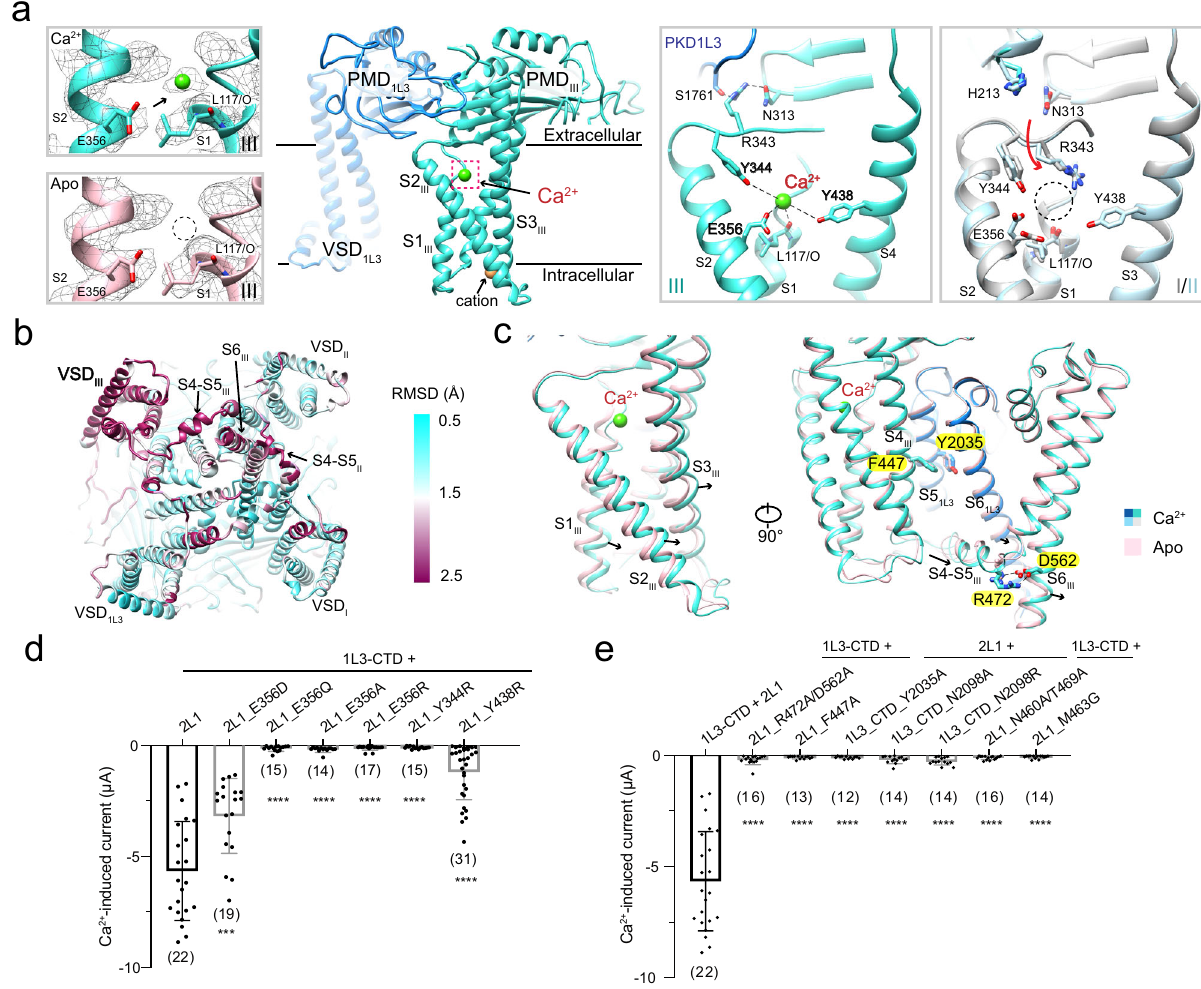
Fig. 4 An unconventional Ca 2 + binding site in VSD III of the heterocomplex may be responsible for Ca 2 + activation. a A Ca 2 + ion is found in the extracellular cleft of VSD III . Left two panels: An extra density is found in VSD III only in the presence of added Ca 2 + . The densities are contoured at 4 σ . Right two panels: Different local conformations of the three VSDs of PKD2L1 reveal the molecular basis for the VSD III -only binding site for Ca 2 + . Arg343 in VSD III projects toward the PMD domain to interact with Asn313 in PMD III and Ser1761 in PKD1L3, whereas in VSD I (silver) and VSD II (pale cyan) it points to the interior of the VSD and occupies the Ca 2 + -binding site. The down conformation of Arg343 in these two VSDs is likely owing to repulsion by His213 from the neighboring PKD2L1 subunit. b VSD III deviates to a larger degree between the apo and Ca 2 + -loaded structures than the other three VSDs. Shown here is the heatmap of RMSD between the two structures. c Relatively minor but important conformational changes of VSD III , S4 – S5 III , and PD between apo and Ca 2 + -loaded states implicate the molecular basis for Ca 2 + -induced channel activation. Left: Shifts of the VSD III segments. Right: Key residues that may mediate channel activation upon Ca 2 + binding to VSD III . d Functional validation of the residues in panel a that constitute the Ca 2 + -activation site. e Functional validation of the residues in panel c that may be involved in the conformational coupling for Ca 2 + -induced channel activation. Data are presented as mean ± SD in the bar graph. Currents of other groups are compared with that injected with PKD1L3-CTD/PKD2L1 with two-sided Student ’ s